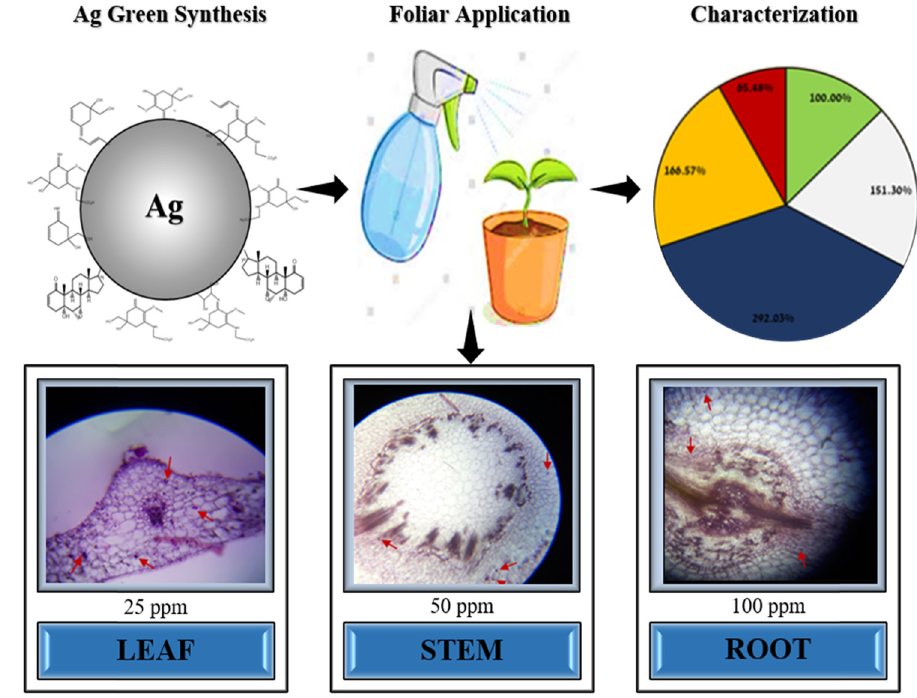
Figure 1: Illustration of foliar spray of silver nanoparticles on L. sativa and their morpho - anatomical